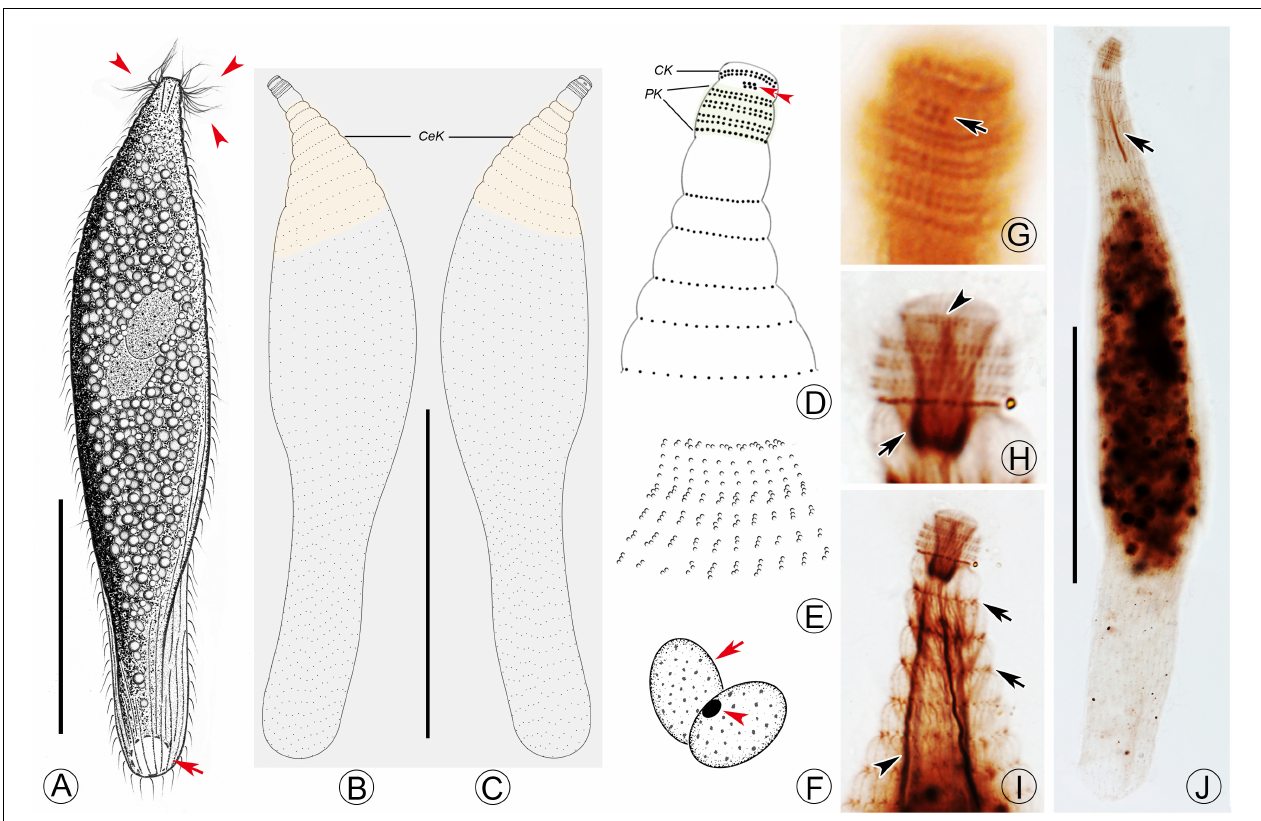
FIGURE 3 | Drawings (A–F) and photomicrographs (G–J) of Lagynus binucleatus sp. n. in vivo (A) and after protargol staining (B–J) . (A) Lateral view of a representative individual, showing general appearance of body, the contractile vacuole (arrow), and the perioral cilia (arrowheads). (B,C) Side views of the holotype specimen, showing ciliary pattern of the cell and cervical kineties (CeK). (D) Ciliary pattern of the anterior portion of the cell, showing the circumoral kinety (CK), brosse (double arrowhead), and perioral kineties (PK). (E) The distribution of cortical granules. (F) Showing the macronuclear nodules (arrow) and micronucleus (arrowhead). (G) Side view of the anterior portion of the cell, showing the brosse (arrow). (H) Side view of the anterior portion of the cell, showing the circumoral kinety (arrowhead) and oral basket (arrow). (I) Side view of the anterior portion of the cell, showing the cervical kineties (arrows) and nematodesmata (arrowhead). (J) Lateral view, showing ciliary pattern and nematodesmata (arrow). CK, circumoral kinety; CeK, cervical kineties; PK, perioral kineties. Scale bars: 70 µ m (A) , 120 µ m (B,C) , 80 µ m (J) .